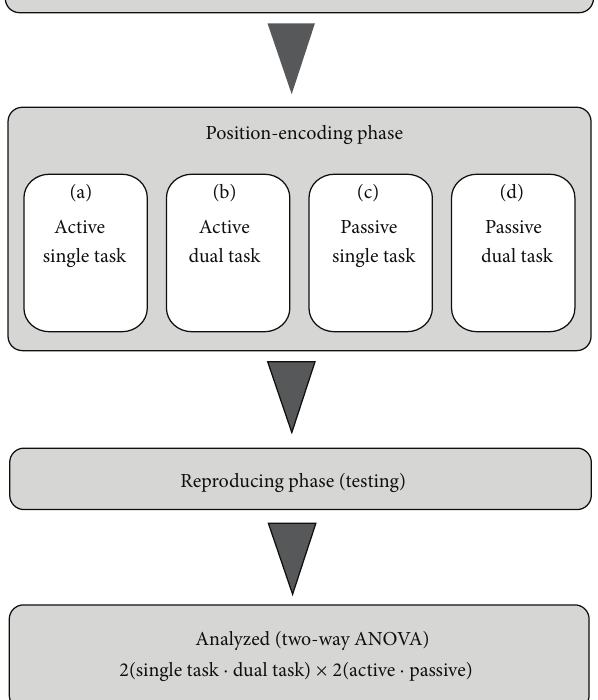
Figure 2: Experimental procedure flow